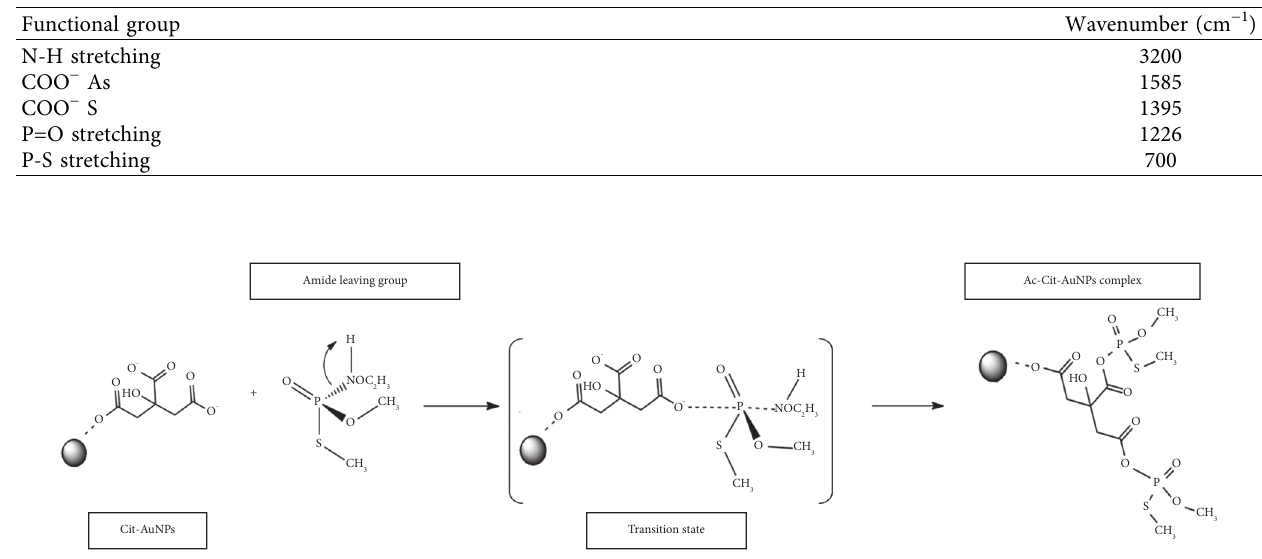
Figure 11: SN2 nucleophilic substitution schematic of colorimetric detection of Ac. Table 2: Images of Ac-Cit-HAuNP and Ac-Cit-MAuNP complex and their average RVs. a